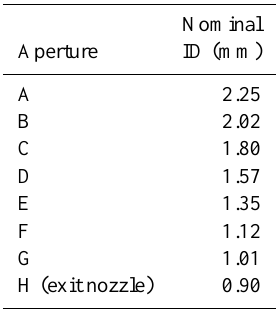
Table 1. Nominal diameters of apertures. Apertures A through G are 0.2mm thick. Aperture H is a conical nozzle.